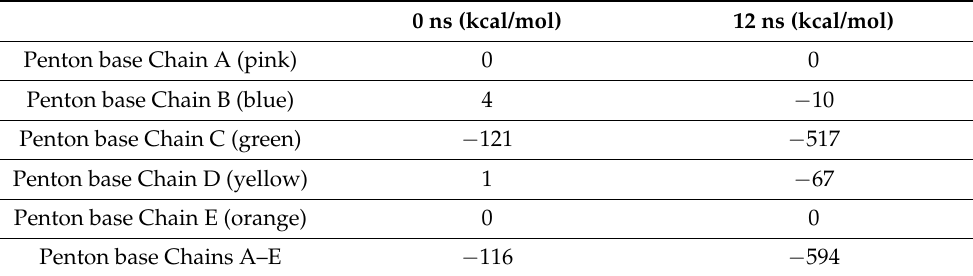
Table 3. Total non-bonded interaction energy between C4b and penton base for model 3 with no covalent linkage to penton base. 0 ns (kcal/mol) 12 ns (kcal/mol) Penton base Chain A (pink)